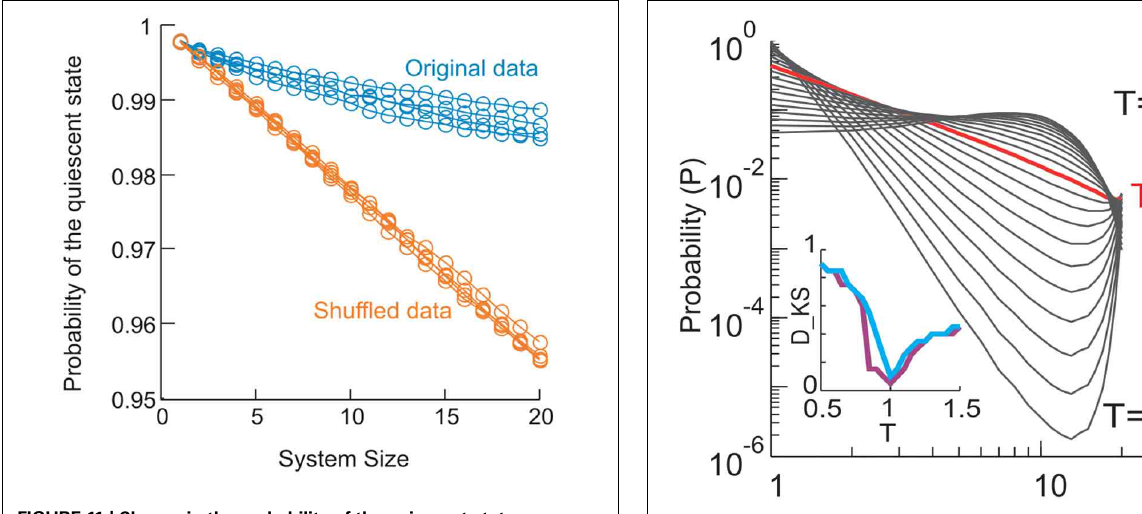
FIGURE 11 | Change in the probability of the quiescent state as a function of system size in the data. For 4 sub-groups analyzed in monkey 1, probability of the quiescent state measured for the original data (blue) is plotted as a function of systems size (from 1 to 20). Probability of the quiescent state measured for corresponding shuffled data (orange) is plotted for comparison. Shuffled data were obtained by randomizing the activity sequence for individual electrodes, which eliminates the correlation among different electrodes but preserves the probability of being active for all electrodes.